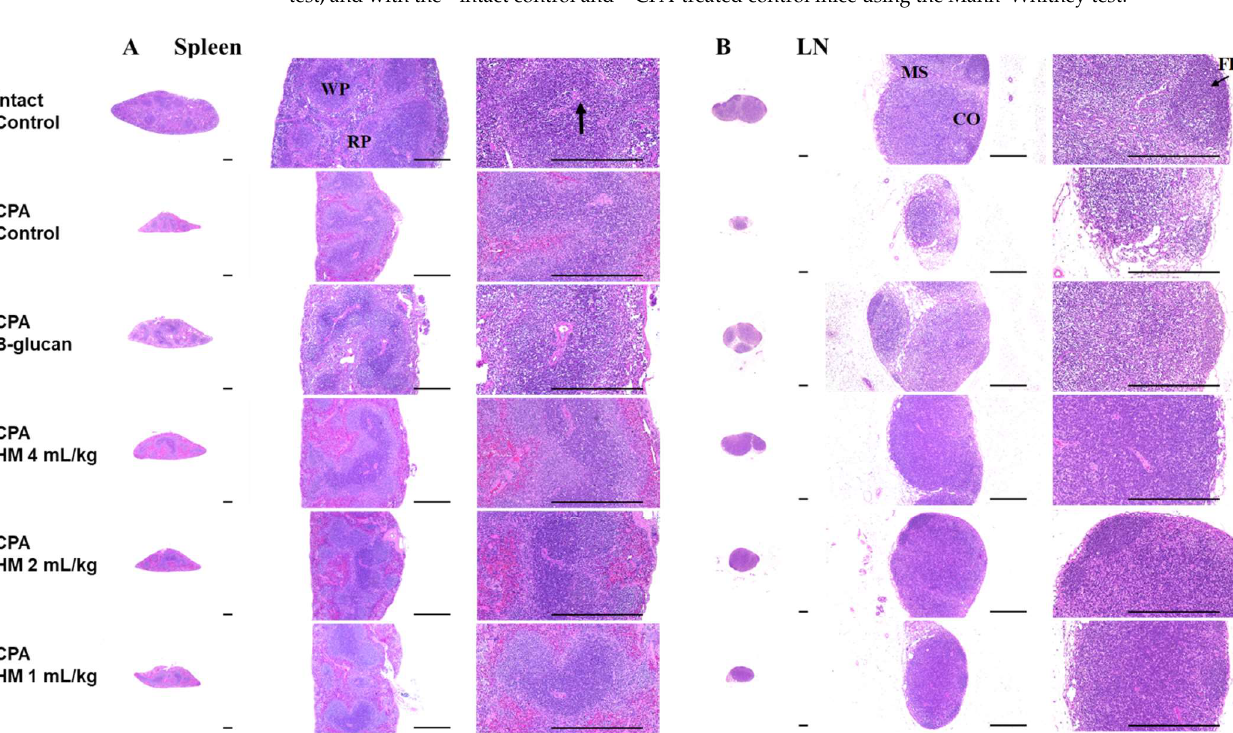
Figure 3. Representative histopathological images of the spleen and left submandibular LN from intact or CPA-induced immunosuppressed mice. All hematoxylin–eosin stained. CPA: Cyclophos- phamide, HM: Hemomine (60% LJG305), LN: Lymph node. Scale bar: 400 µ m. ( A ) Splenic histopathol- ogy. WP: white pulp, RP: red pulp, Arrow: central arteriole. ( B ) LN histopathology. CO: cortex; MS: medullary sinus, FL: follicle.